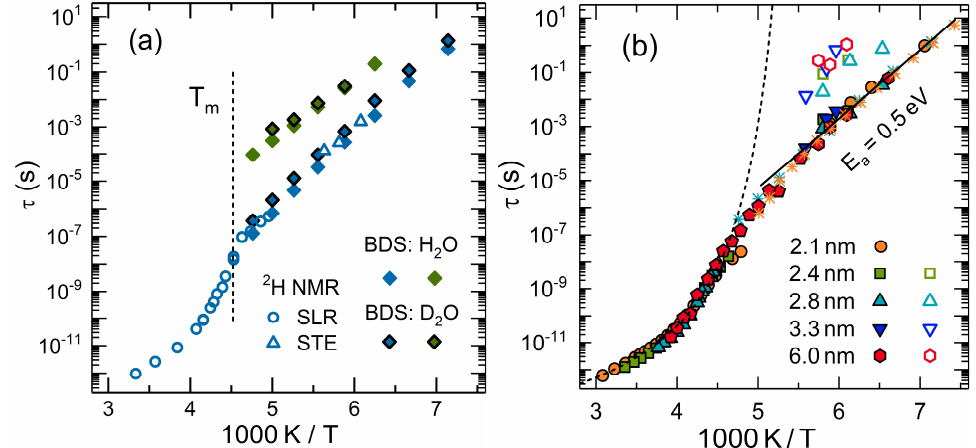
Figure 4. Correlation times of water reorientation in MCM-41 and SBA-15: ( a ) Results for H 2 O and D 2 O in MCM-41 pores with a diameter of 2.8 nm from BDS, 2 H spin-lattice relaxation (SLR), and 2 H stimulated-echo (STE) experiments [215]. The dashed line marks the melting temperature T m of water in these confinements, as obtained from DSC (adapted from [215]). ( b ) Results for H 2 O and D 2 O in MCM-41 pores with the indicated diameters from 2 H NMR [213] and BDS (stars) [212,215]. The dashed line is an interpolation of the high-temperature data with a Vogel-Fulcher-Tammann relation. The solid line is an Arrhenius fit of the low-temperature results, yielding an activation energy of 0.5 eV (adapted from [213]).